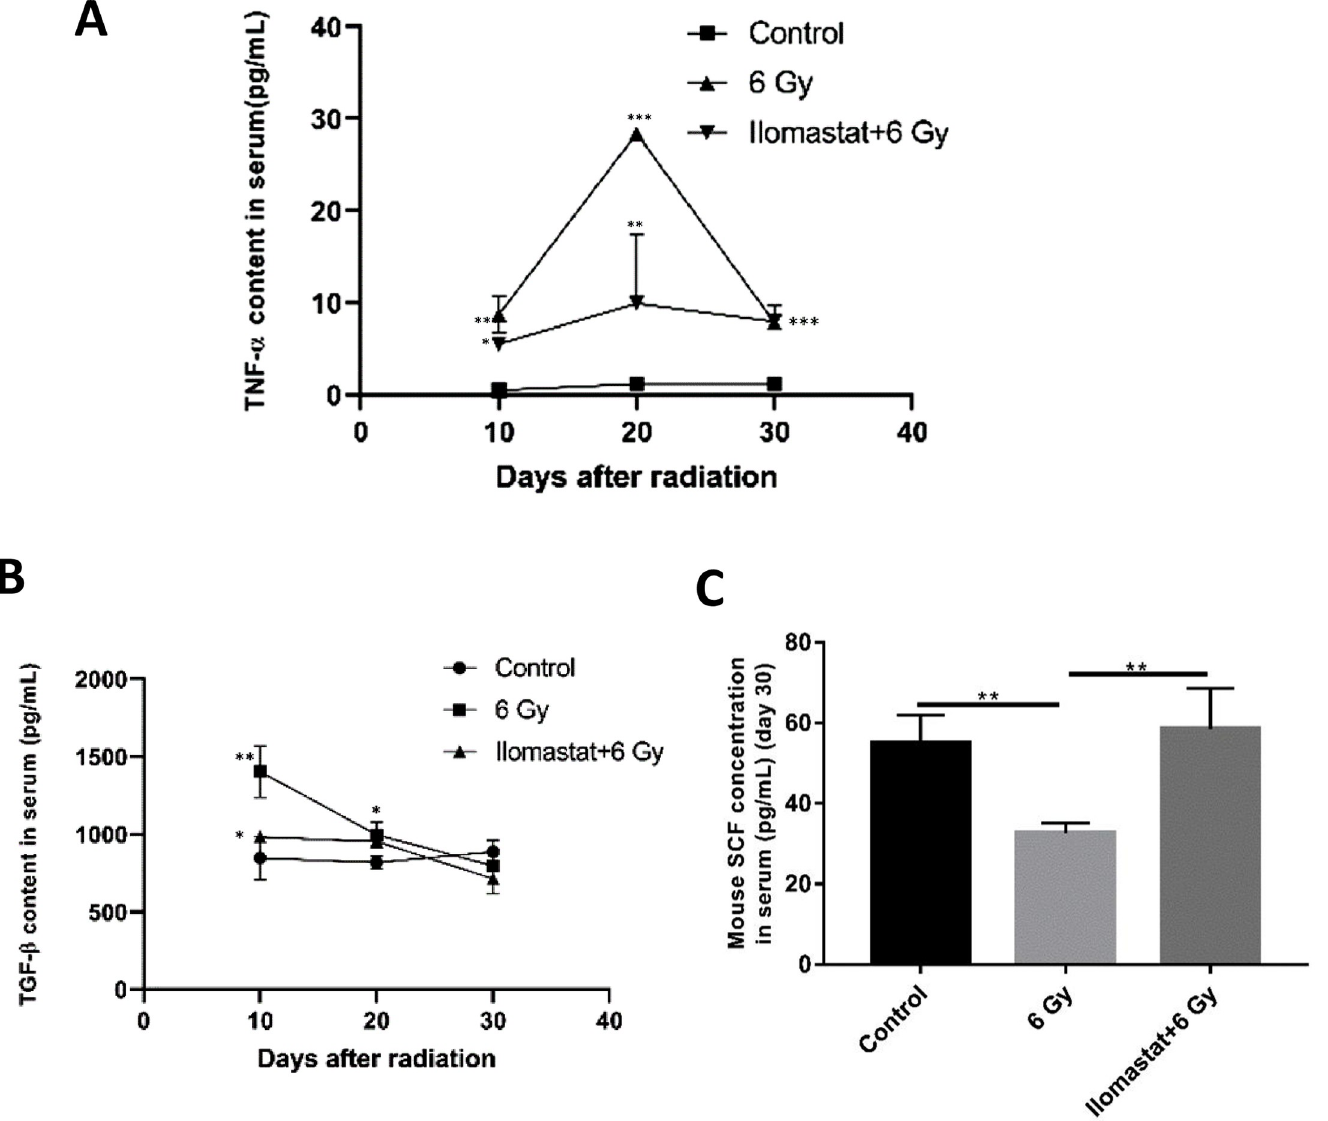
Fig 1. Ilomastat pretreatment influences the cytokines level. The levels of TNF-a (A) and TGF-b1 (B) at day 10, 20 and 30, and SCF (C) at day 30 in mouse serum were measured by colorimetric enzyme-linked immunosorbent assay (ELISA). The final concentration of TGF- β 1, TNF- α and SCF in each serum sample were corrected for sample dilution and presented in pg/mL. All error bars indicate SEM (n = 8). � P < 0.05; �� P < 0.01; ��� P < 0.001.